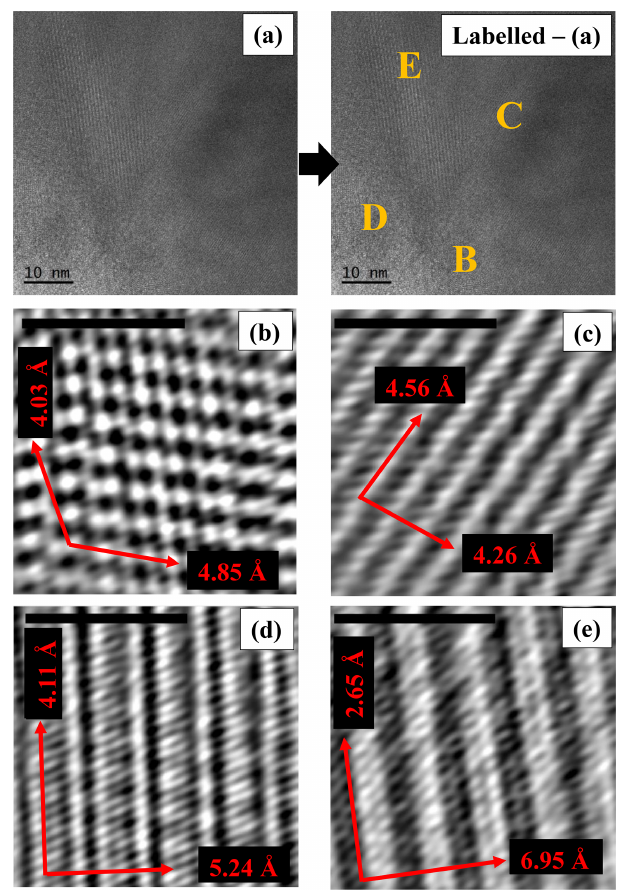
Figure 12. (a) High-resolution TEM micrograph of a region in which several orientations of the lattice are visible. The yellow la- bels (B, C, D, E) show the ROIs used to determine the main crystal- lographic directions and the d spacings of the corresponding planes displayed at higher magnifications in the IFFT images shown in panels (b) , (c) , (d) , and (e) . Standard deviations ( σ n − 1 ) for the d spacings of the planes that correspond to the crystallographic di- rections shown by red arrows are indicated in the text only. Scale bars in panels (b) , (c) , (d) , and (e) are 2nm.